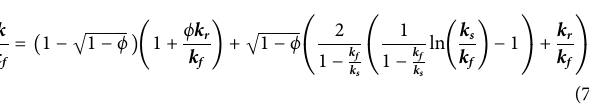
Frontiers in Materials |